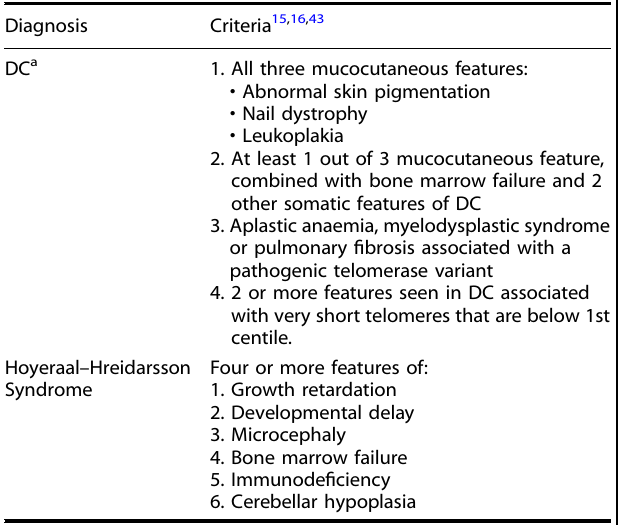
Table 2. Summary of dyskeratosis congenita diagnostic criteria. Diagnosis